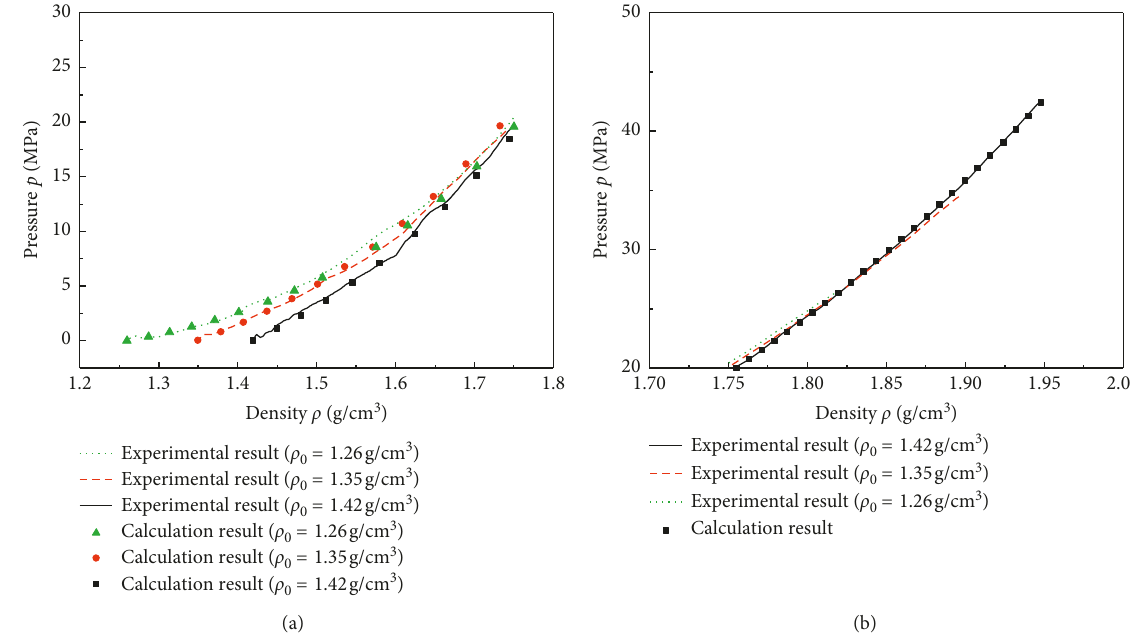
Figure 14: Comparison between experimental and calculated results. Comparison of (a) the first segment and (b) the second